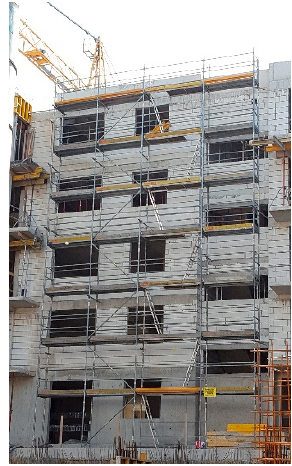
Figure 6. Example of façade scaffold with an area of 30-300 m 2 (authors’ archive).